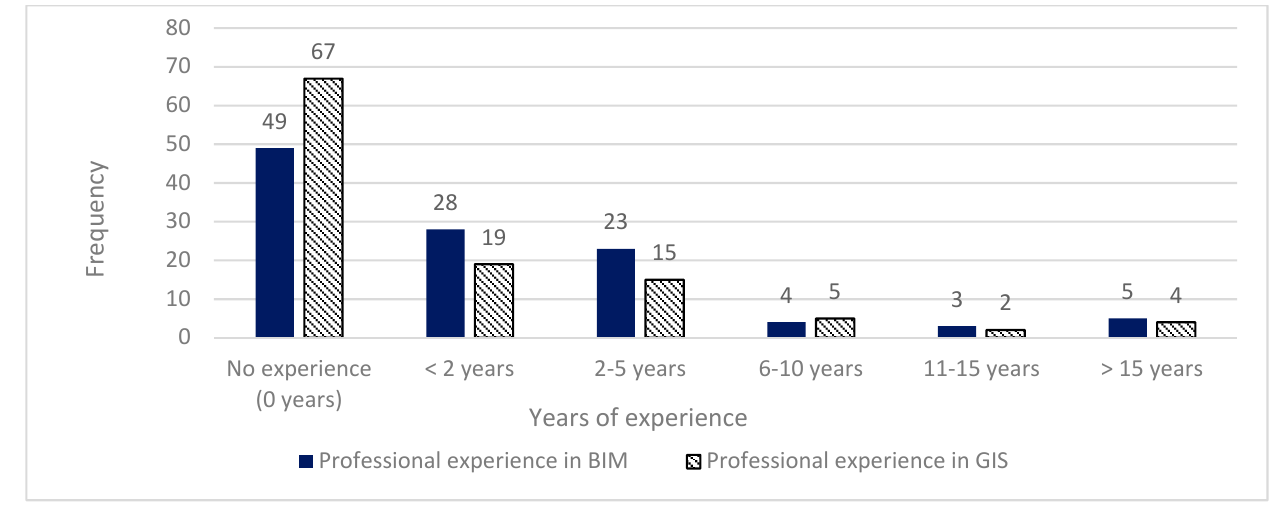
Figure 1. Years of experience of BIM and GIS.